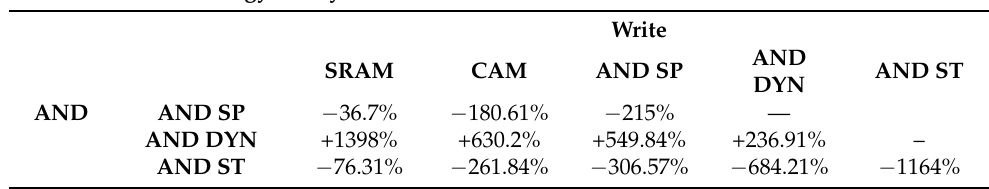
Table 12. Percentage differences in the write and AND energy-delay products among the arrays. Each value corresponds to the increase, expressed in percentage, in the energy-delay product of the memory on the corresponding row with respect to the one of the memory on the corresponding column. The data are extracted from Table 3. Energy–Delay Products Relative Variations: AND vs. Write